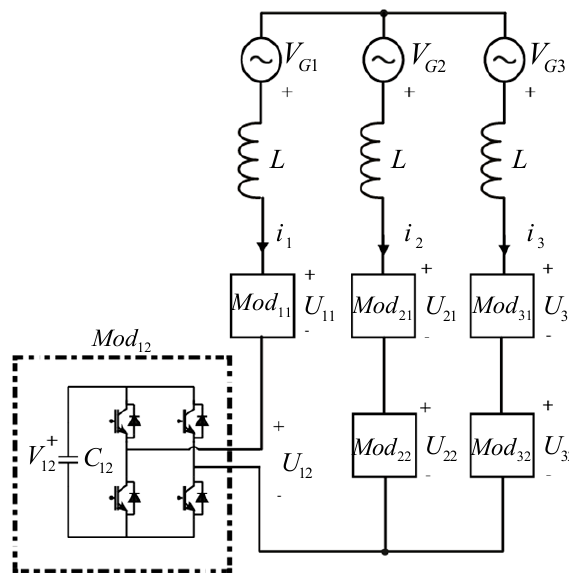
Figure 1. Scheme of the CHB topology. The figure also shows the nomenclature considered in this paper, including the sign criteria and the ordering of the subscripts. paper, including the sign criteria and the ordering of the